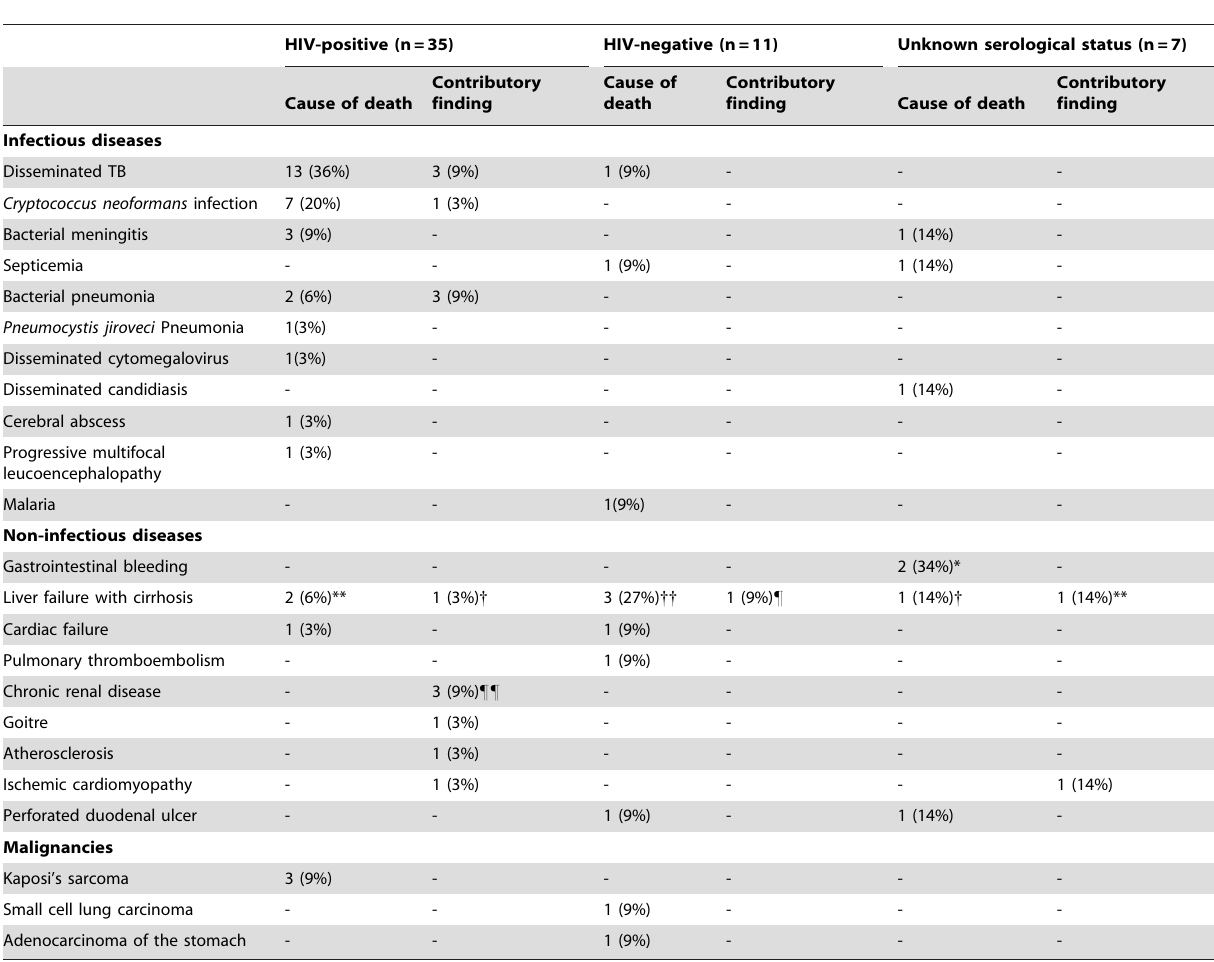
Table 2. Causes of death and contributory findings according to HIV-serological status.